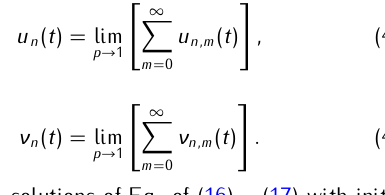
Figure 4. Explicit numerical solutions of Eq. (17) for ν (41) at α = 1 , β = 1 . Redline α = 1 , β = 1 ; Dashed line with c = 0 . 1 , d = 0 . 1 and α = 1 4 4 t = 5